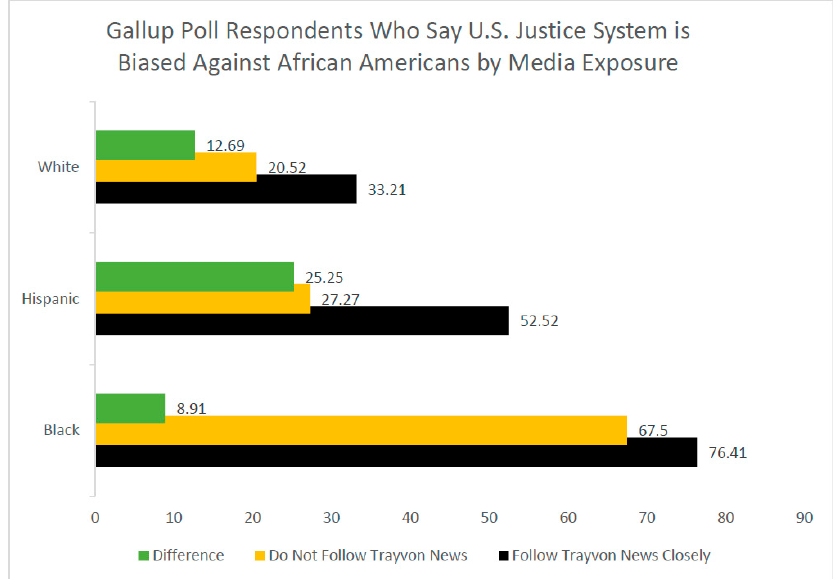
Figure 2. Percent of Respondents Indicationg System is Biased by Media Exposure and Race.